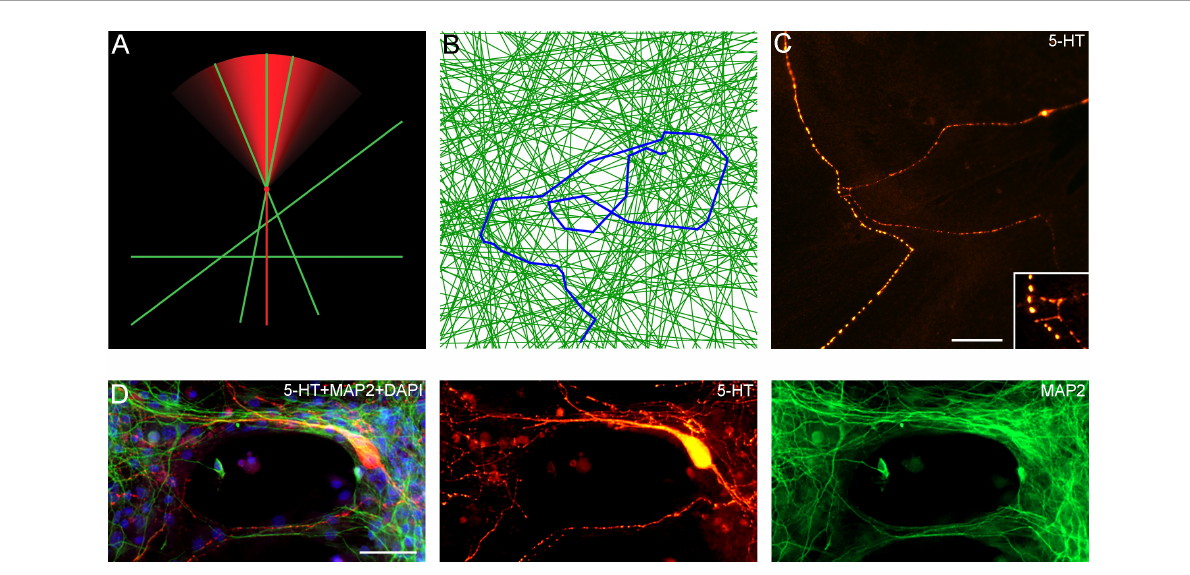
FIGURE12 (A) A diagram showing the hypothetical choices available to an advancing serotonergic axon (red) that can choose any of the available neurites (green), provided they fall within its sector of possible directions. The sector is modeled with the von Mises distribution, in which, the mean direction µ is aligned with the current direction of the fiber and the concentration parameter κ = 10. (B) A simulated walk of a fiber (blue) that can advance only along available neurites (green). In the simulation, 200 randomly-oriented lines were used, and the fiber advanced through 350 intersections. At each intersection, it could move in the current direction (a 0 ◦ -turn), turn “left” or “right” (at the available angles), or turn backward (a 180 ◦ -turn). The probabilities of the four events were calculated using the von-Mises distribution with µ = (0, 0) and κ = 5, and one event was drawn. The simulation was performed in Wolfram Mathematica 13.0. The Mathematica script can be used to generate more unique walks ( Supplementary Data Sheet 1 ). (C) A comparable configuration of 5-HT + axons in a glia-neuron coculture at DIV 15, visualized with epifluorescence microscopy. The inset shows potential contact points. Scale bar = 20 µ m. (D) Serotonergic axons (5-HT + /MAP2–, red) traveling along bridges of MAP2 + (green) neurites, visualized with epifluorescence microscopy. Scale bar = 50 µ